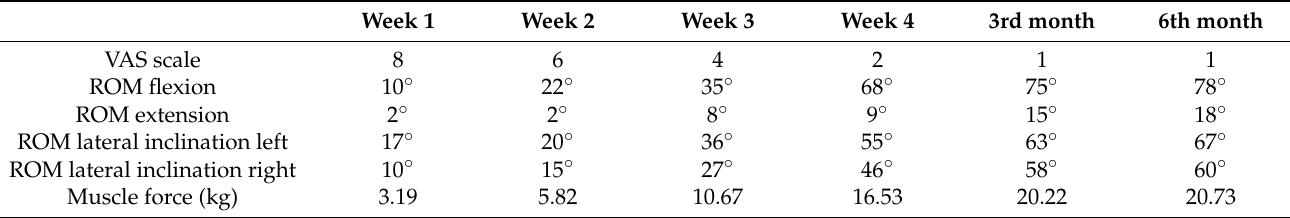
VAS, visual analogue scale; ROM, range of